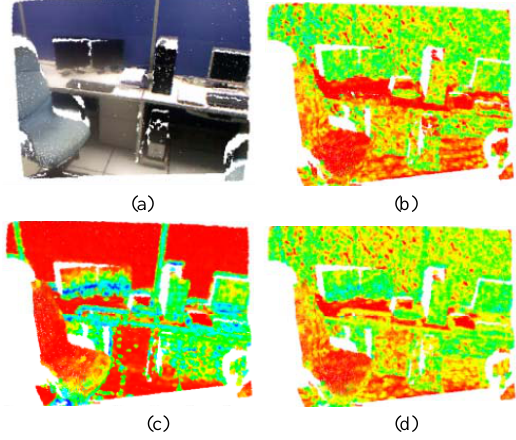
Figure 3. Example of the point cloud curvature and the second- order moments of the color map color. (a) Original point cloud. (b) Corresponding curvature distribution. (c)The second-order moment of the color feature (Hue element). (d) Hybrid